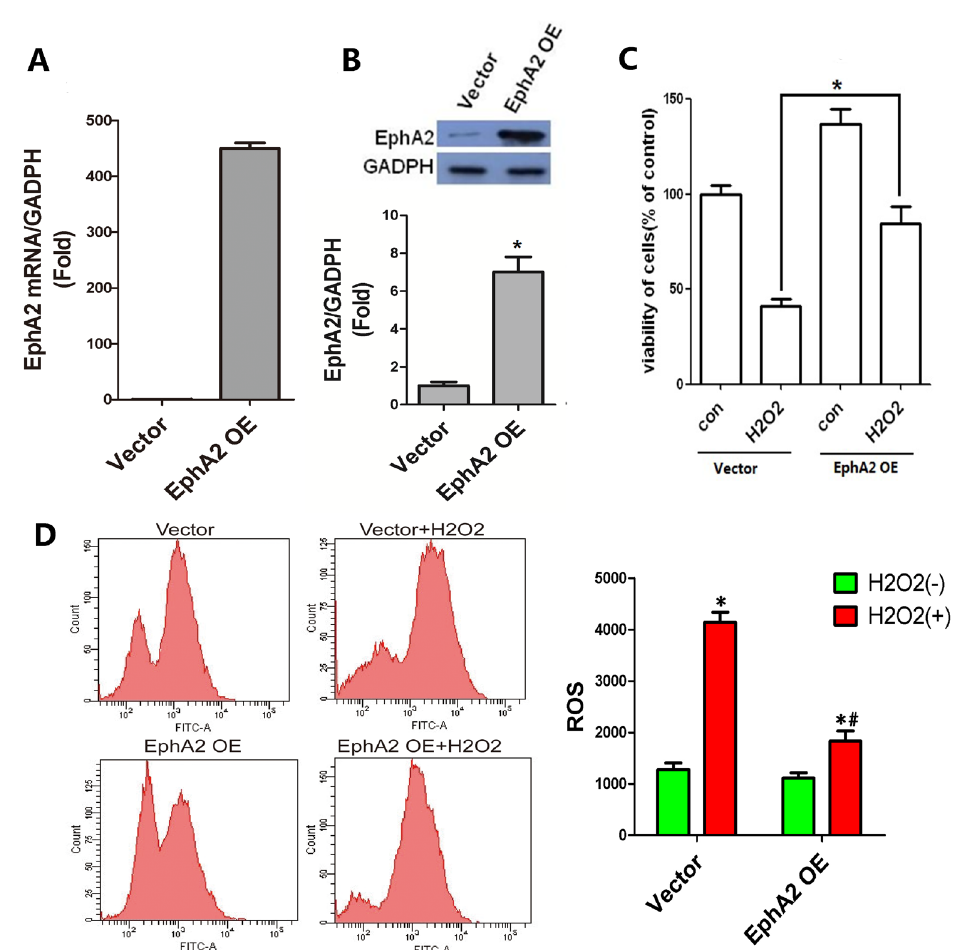
O -treated SRA01/04 cells. SRA01/04 cells were transfected 2 2 O for 24 h. (A-B) QRT-PCR and WB were performed to 2 2 O group. 2 2